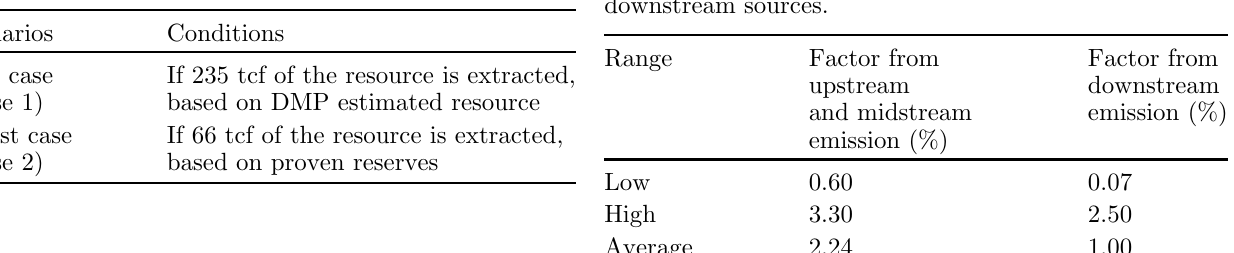
Table 1. Scenarios under investigation.